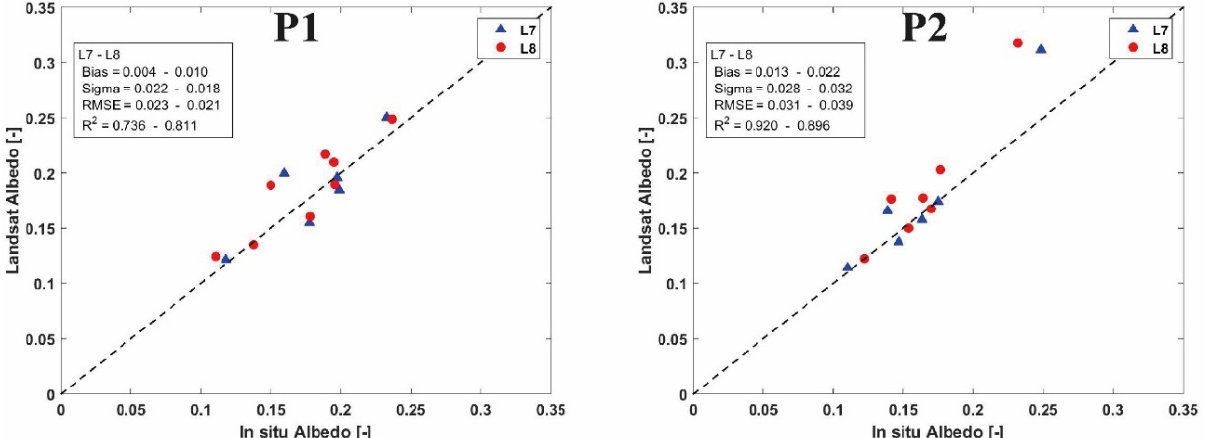
Figure 2. Comparison between surface albedo estimated by Landsat against in situ albedo for flood (P1) and drip (P2) wheat sites.